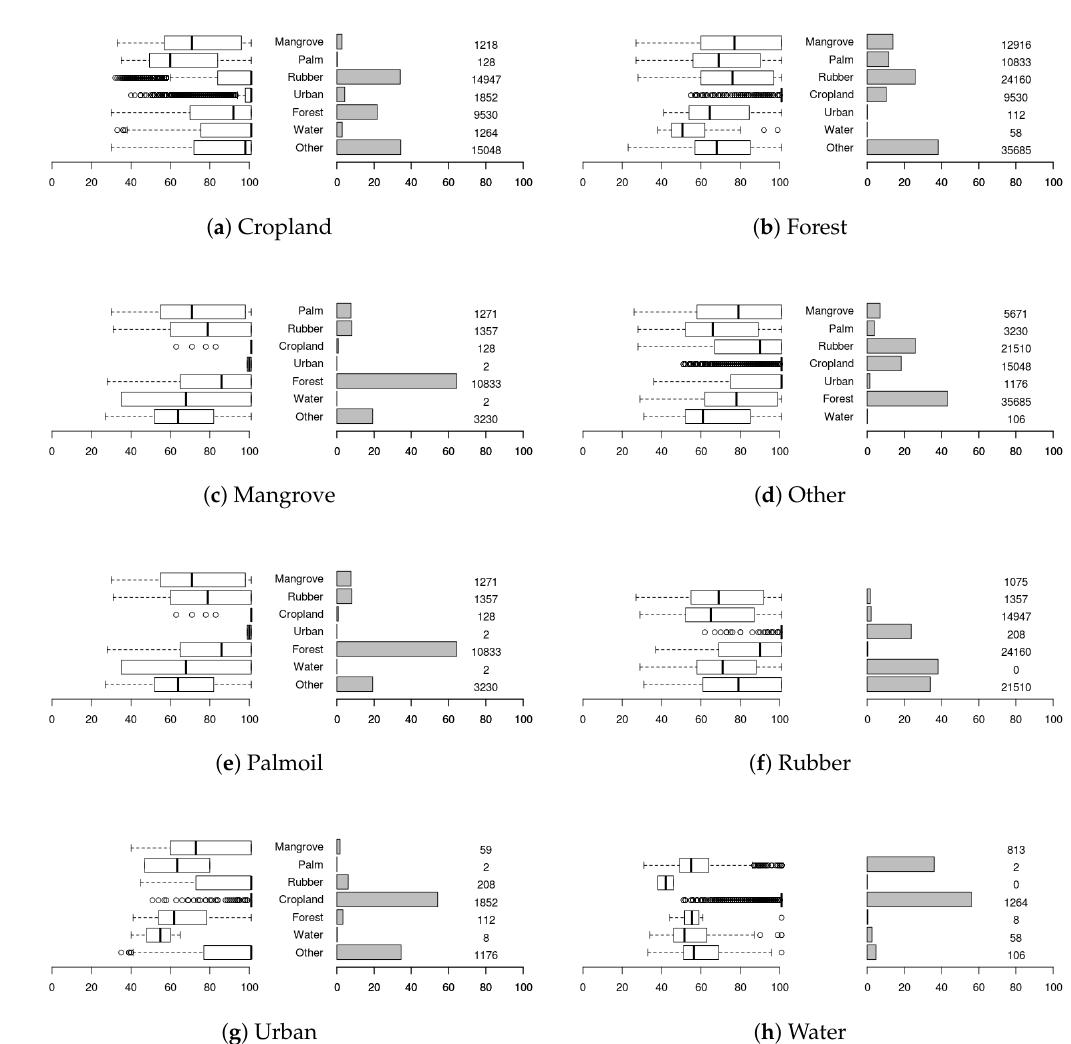
Figure 8. Changes between categories: plots on the left show the change from the main class as a percentage, the plots on the right the probabilities associated with those changes. The numbers indicate the amount of data points that were